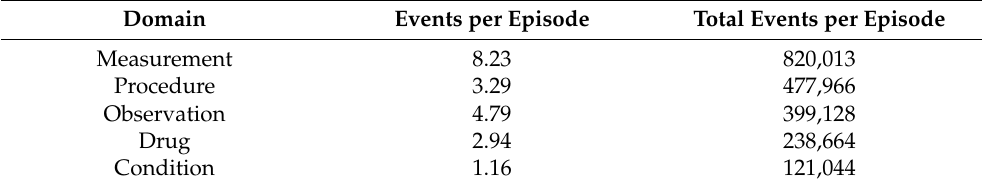
Table 4. Events per Episode and total events stored in the Episode_Event table.